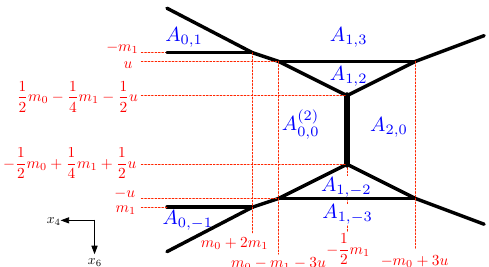
in Figure 26. The regions for the largest A ( m ) k;l Region 6 of the E 2 theory.